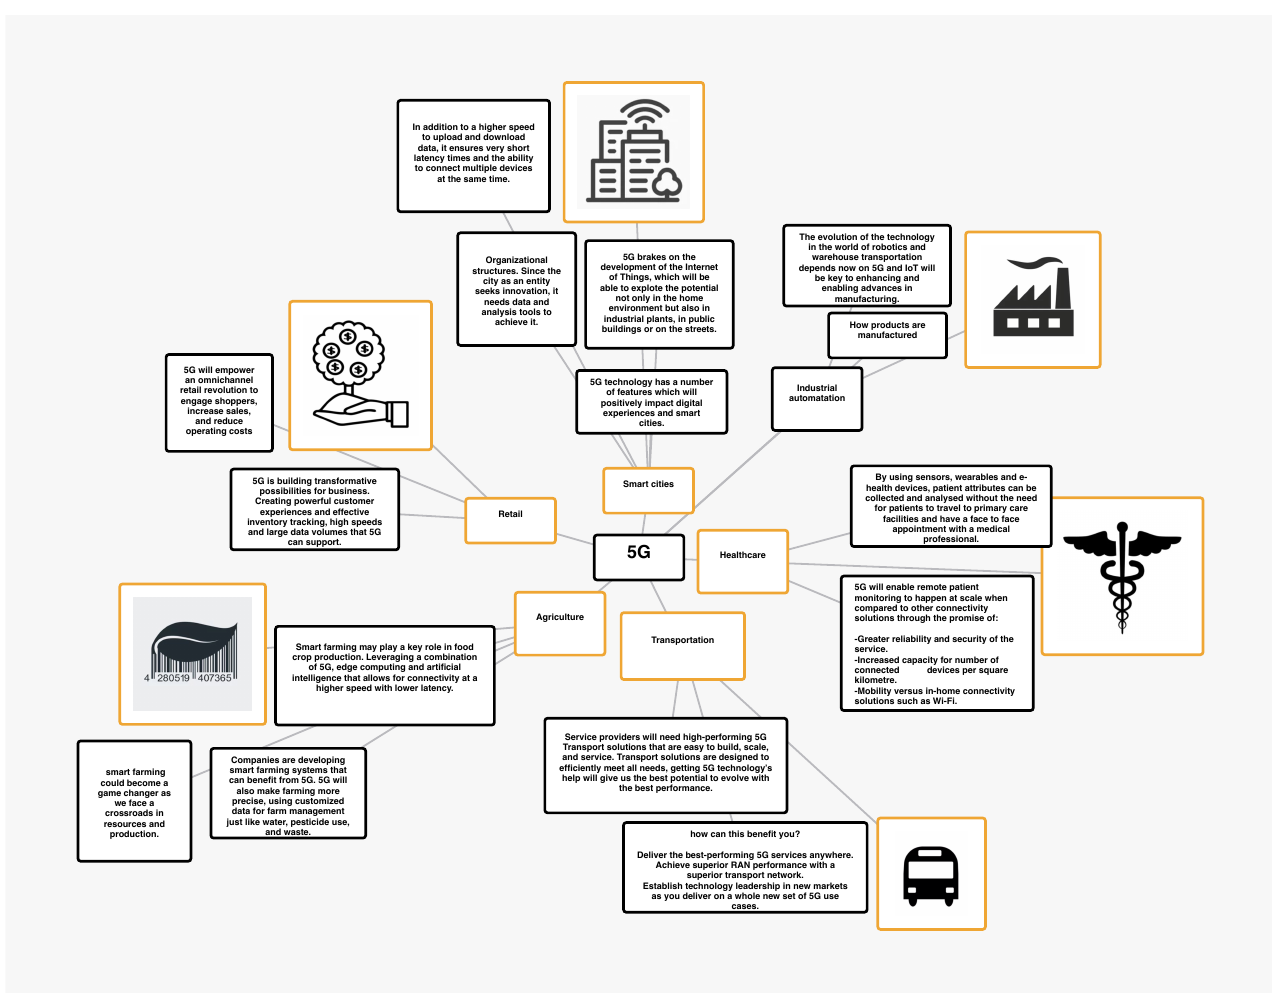
Figure 2. 5G applications impacted by IoT